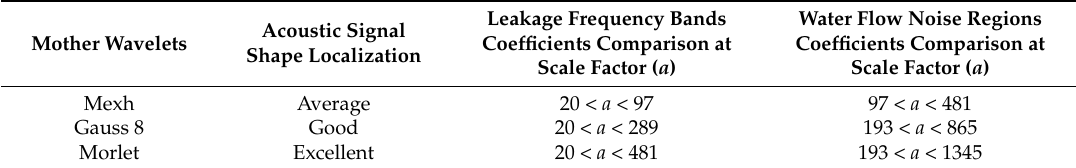
Table 1. The comparison of most correlated mother wavelets parameters regarding the acoustic signal.